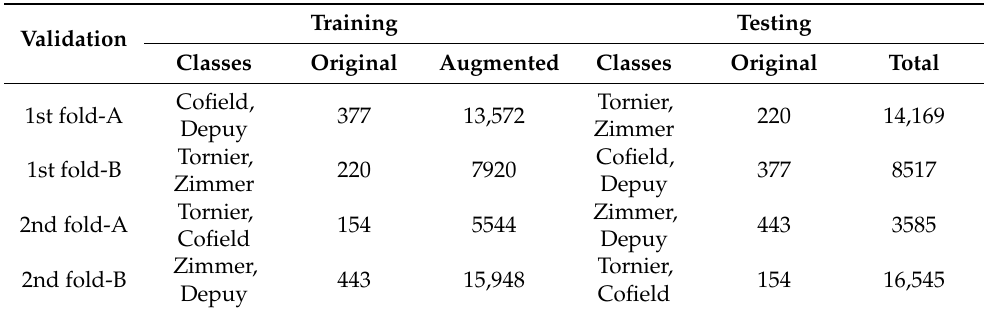
Table 15. Summary of two-fold cross-validation of training and testing data for open-world configu- ration (unit: images).